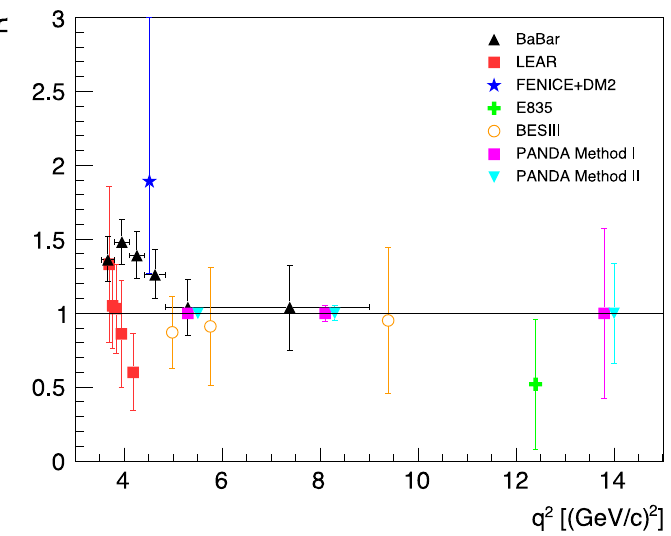
Figure 1. Expected statistical precision of the determination of the proton form factor ratio R = | G | / | G | at PANDA as a function of q 2 , compared with the existing data (see [13] and references E M